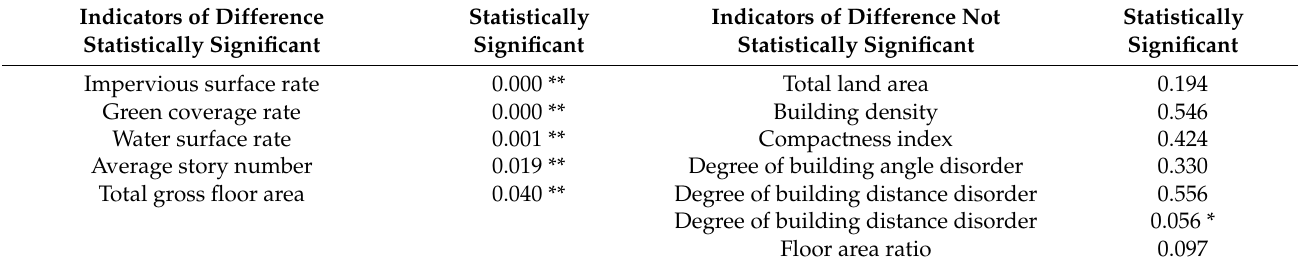
Table 3. Results of Mann–Whitney U test of morphological